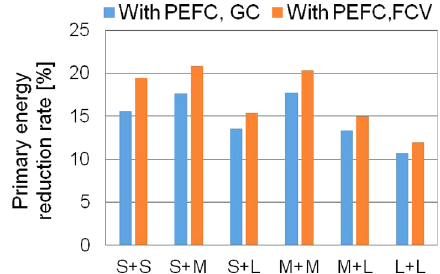
Fig. 11. PE reduction rate based on the case without the PEFC system and with